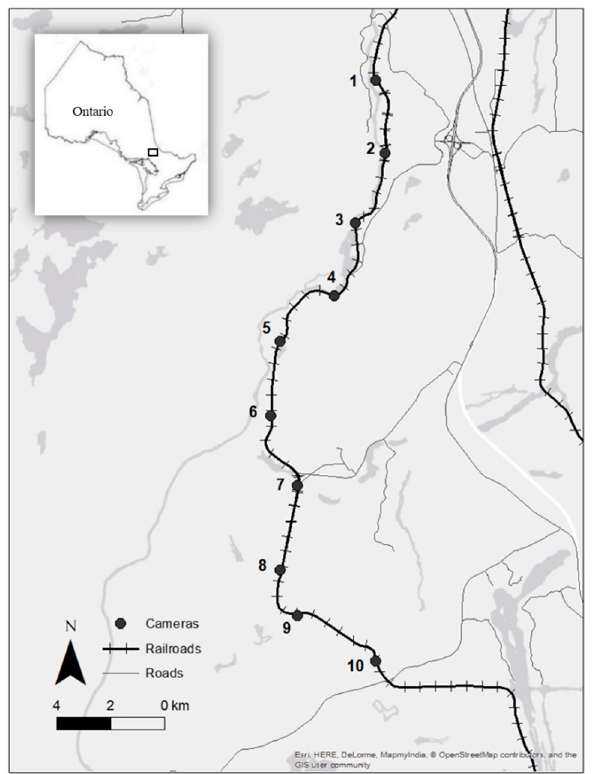
Figure 1. Trail camera placement along the 20 km studied section of the Canadian National Railway, approximately 20–40 km south of the City of Greater Sudbury, ON, Canada.